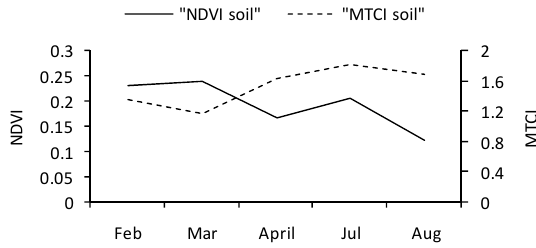
Figure 7. NDVI and MTCI soil spectral signatures trend.